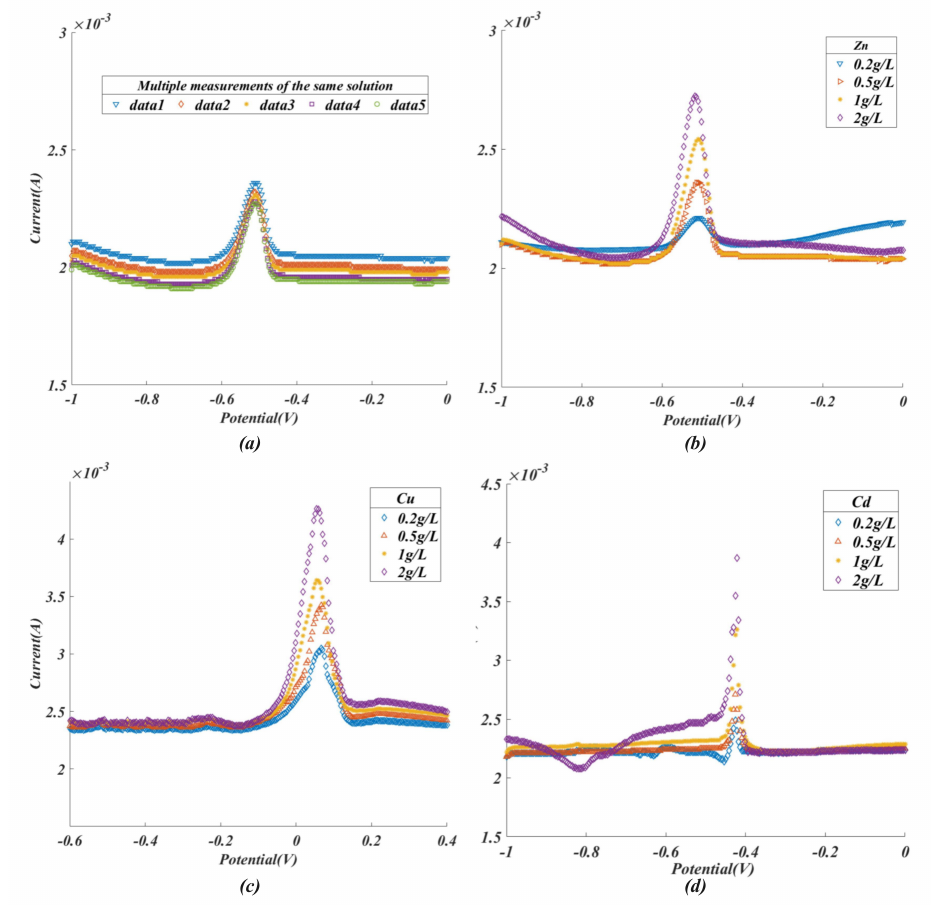
Figure 3. ( a ) The results of the multiple replicate tests of a 0.5 g/L solution of zinc chloride dissolved in a 0.1 mol/L potassium chloride substrate. Data 1–data 5 are the data curves for the different measurement times; ( b ) the SWV data for the Zn 2 + solution at different concentrations; ( c ) the SWV data for the Cu 2 + solution at different concentrations; ( d ) the SWV data for the Cd 2 + solution at different